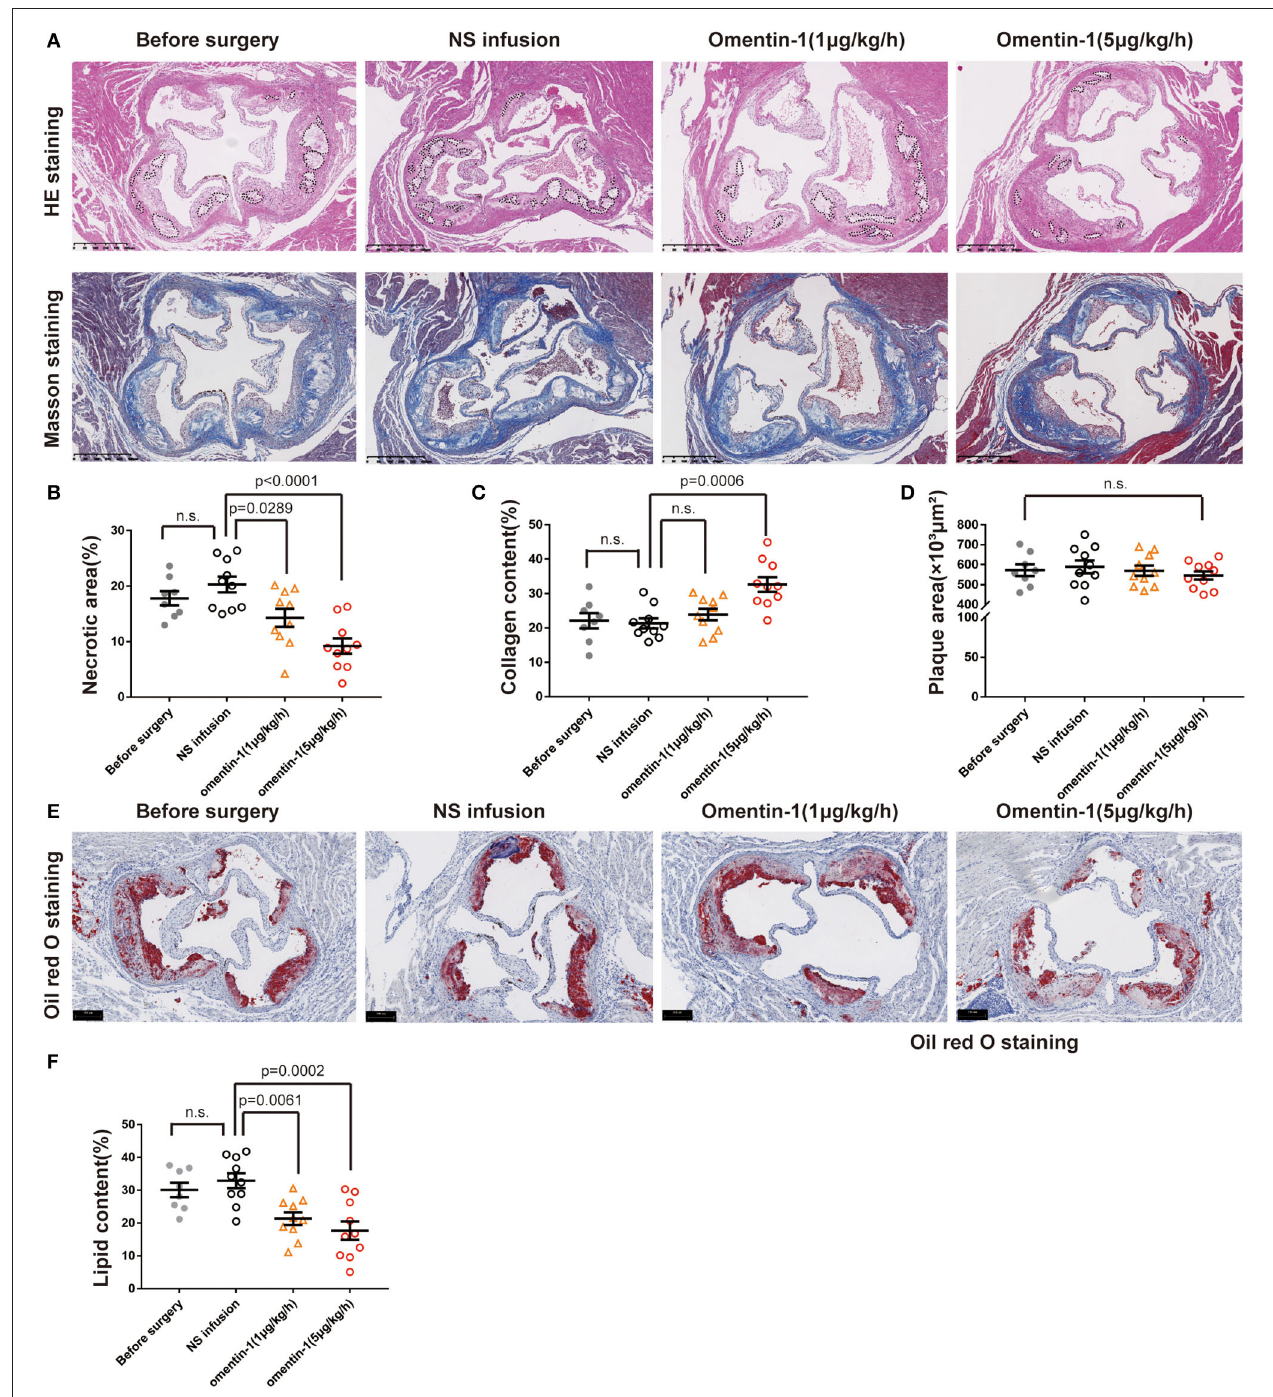
FIGURE 1 | Infusion of omentin-1 enhanced plaque stability in ApoE − / − mice. (A) Representative images of aortic root lesion sections of ApoE − / − mice stained by hematoxylin and Masson’s trichrome. (B) Graph shows the formation of necrotic cores. The formation of necrotic cores (pointed out by dot line) was assessed by calculating the proportion of necrosis area in the plaque (n 1 = 8, n 2,3,4 = 10). (C) Graph shows the collagen content of atherosclerosis (AS) plaque. Collagen content was expressed in the proportion of collagen fiber (blue) in the plaque area (n 1 = 8, n 2,3,4 = 10). (D) Graph shows the size of the AS lesion in each group. No significant difference was found between the experimental groups and control groups (n 1 = 8, n 2,3,4 = 10). (E) Representative images of the aortic root sections of mice stained by oil red O. (F) Graph show the lipid content (red) in the plaque area. The lipid content was expressed in the proportion of oil red positive area in plaque area (n 1 = 8, n 2,3,4 = 10). All data in this figure were presented as mean ± SEM [n.s., non-significant; n 1 , the number of subjects in Before Surgery group; n 2 , the number of subjects in normal saline (NS) infusion group; n 3 , the number of subjects in group infused with omentin-1 (1 µ g/kg/h); n 4 , the number of subjects in group infused with omentin-1 (5 µ